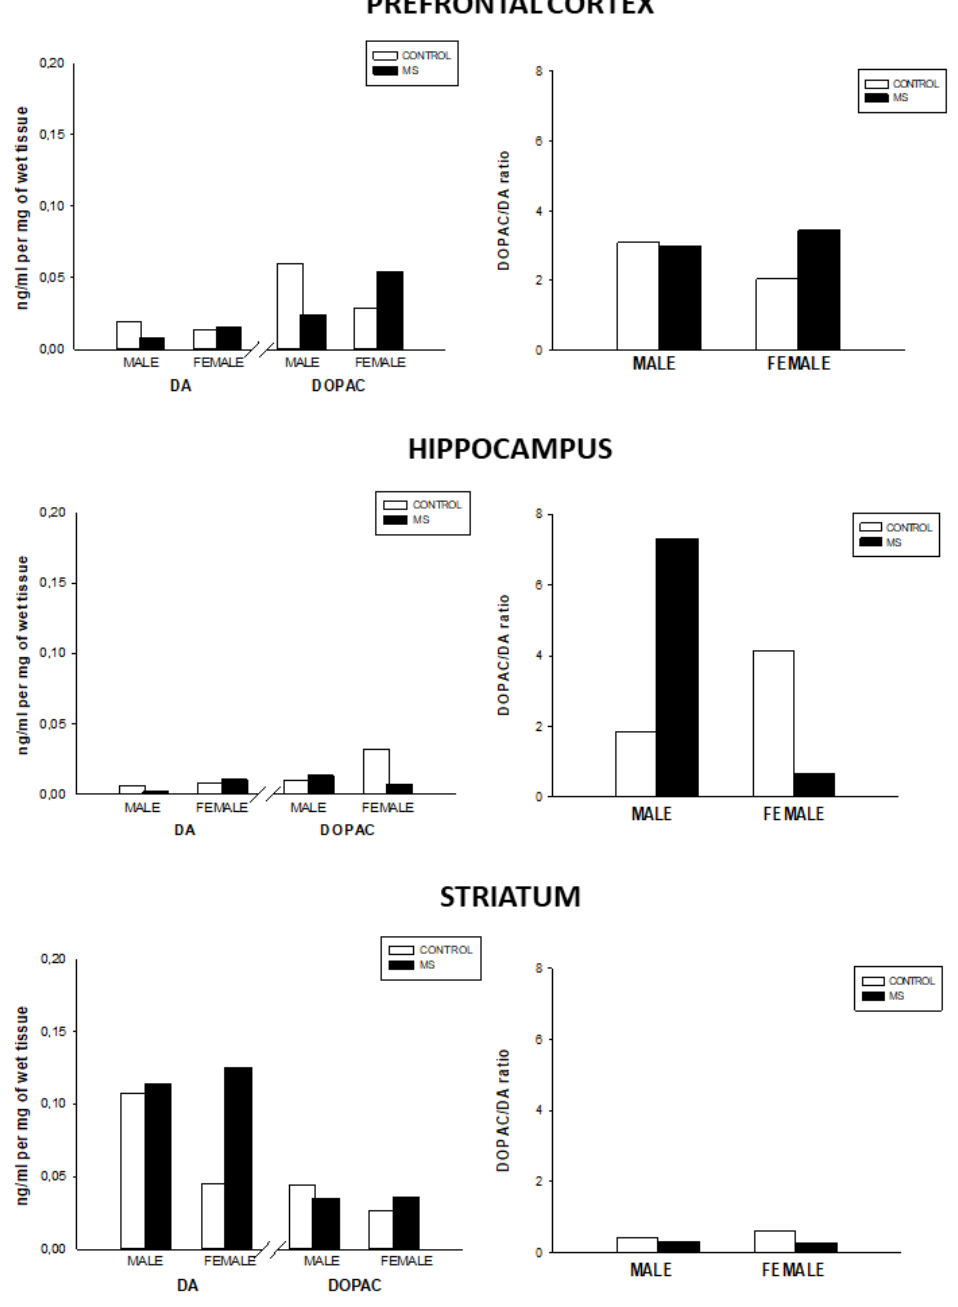
Figure 2. DA, DOPAC levels (ng / mL per mg of wet tissue), and DA turnover ((DOPAC / DA ratio) in the prefrontal cortex, hippocampus, and striatum for the control and MS groups. However, MS males had lower DOPAC in the prefrontal cortex as compared to the male control group. On the other hand, female MS rats showed increased dopamine turnover in the prefrontal cortex but decreased DA turnover (DOPAC / DA ratio) in the hippocampus. Conversely, MS males showed increased DA turnover in the hippocampus.